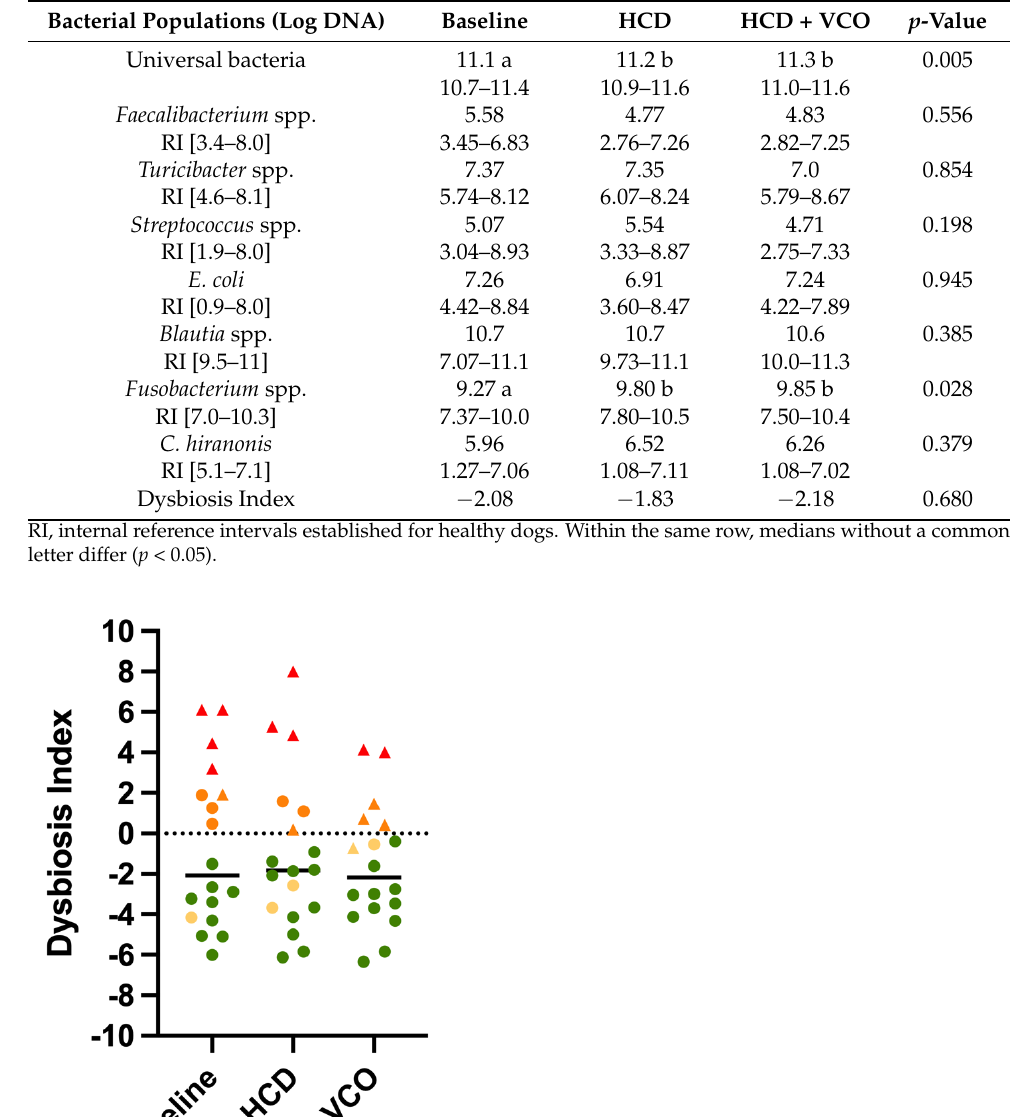
Table 6. Fecal abundance of selected bacterial populations based on qPCR, in canine fecal samples collected from dogs during the first visit (baseline), after receiving a home-cooked diet for 7 days (HCD), and after supplementation with virgin coconut oil (HCD + VCO). Data are expressed as median and range.